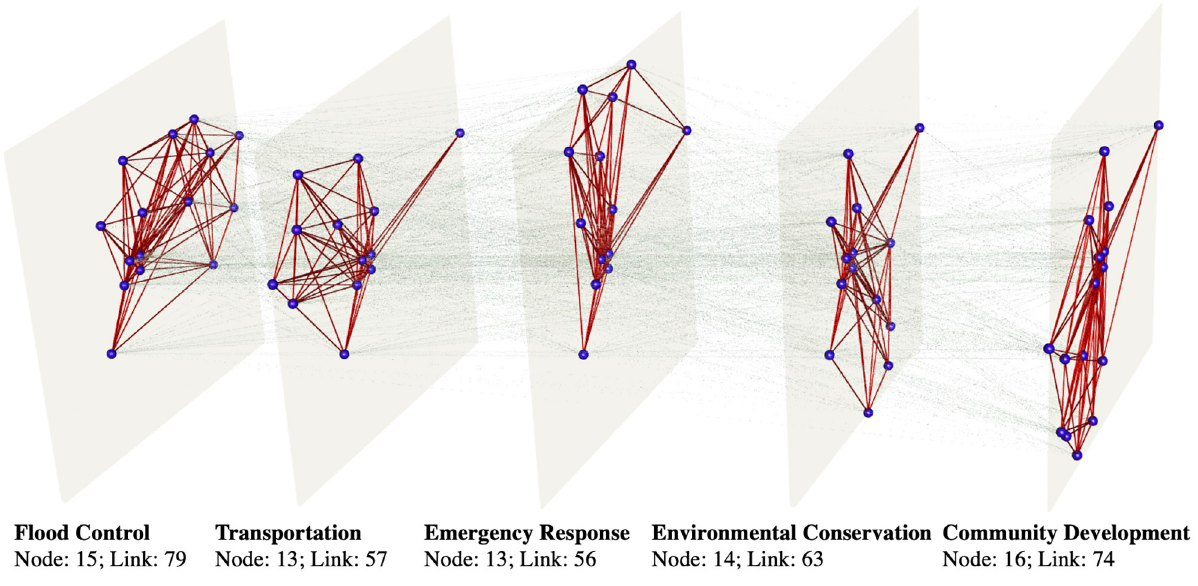
Fig 6. The multilayer collaboration network of 35 organizations.